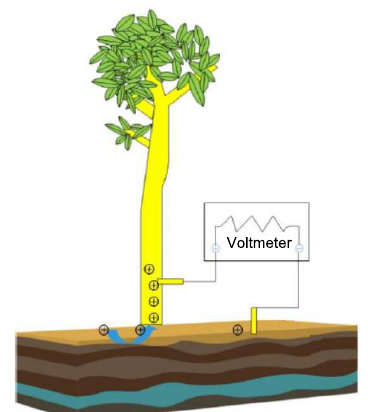
Figure 2. Schematic diagram of tree-energy